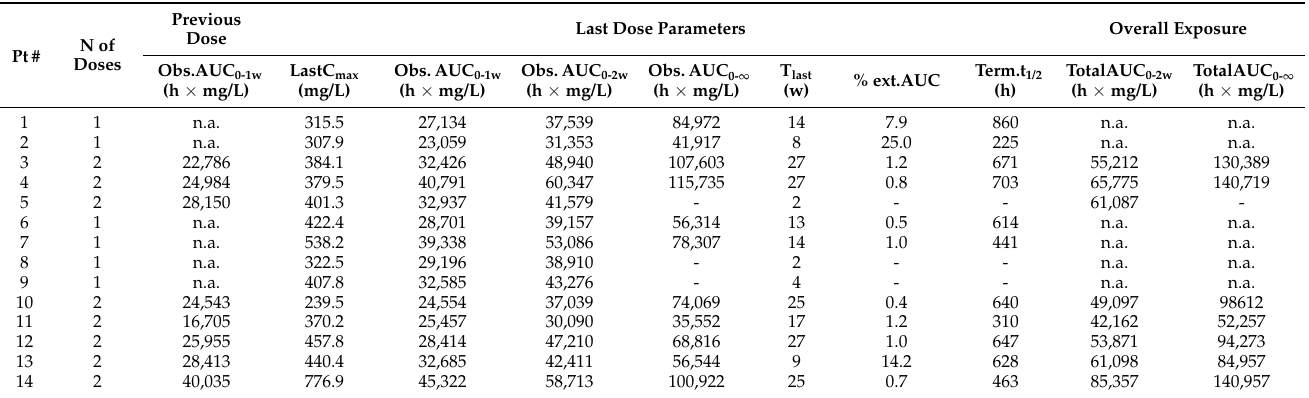
Table 3. Summary of PK parameters measured for each patient. Total AUCs for dual dose group were calculated as the sum of the first dose AUC 0-1w with the corresponding second dose